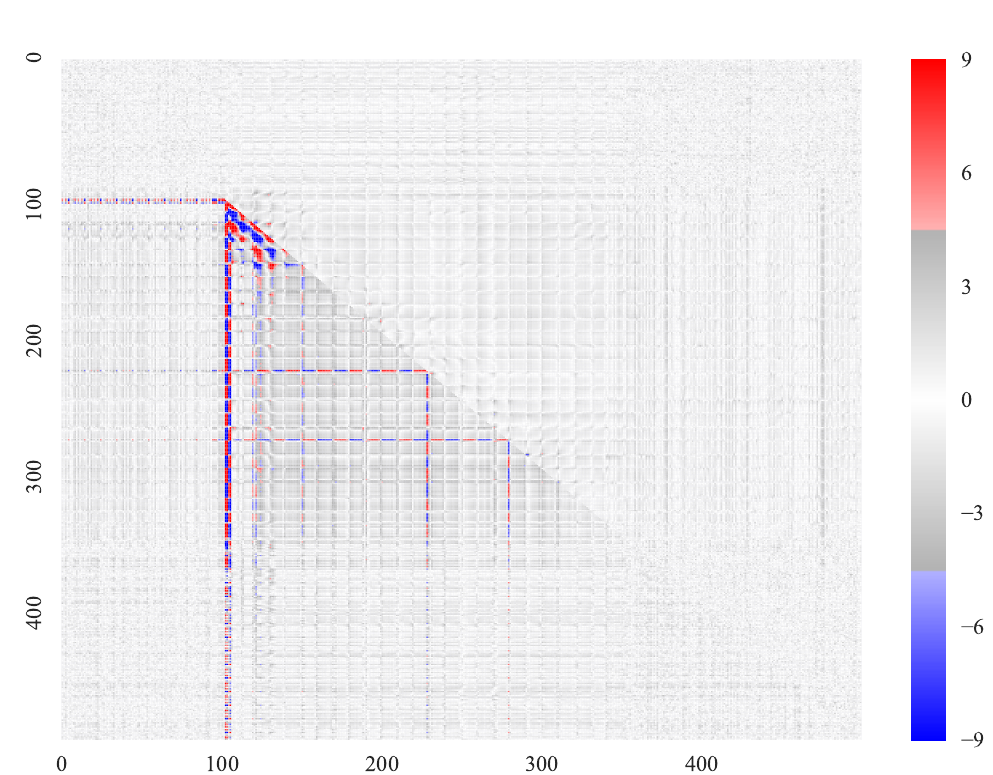
Figure 8: Bivariate fixed-vs.-random t-test results for AES-128. The lower left corner shows the results when mask generation is disabled using 100k traces. The upper right corner shows the results when mask generation is enabled using 1 billion